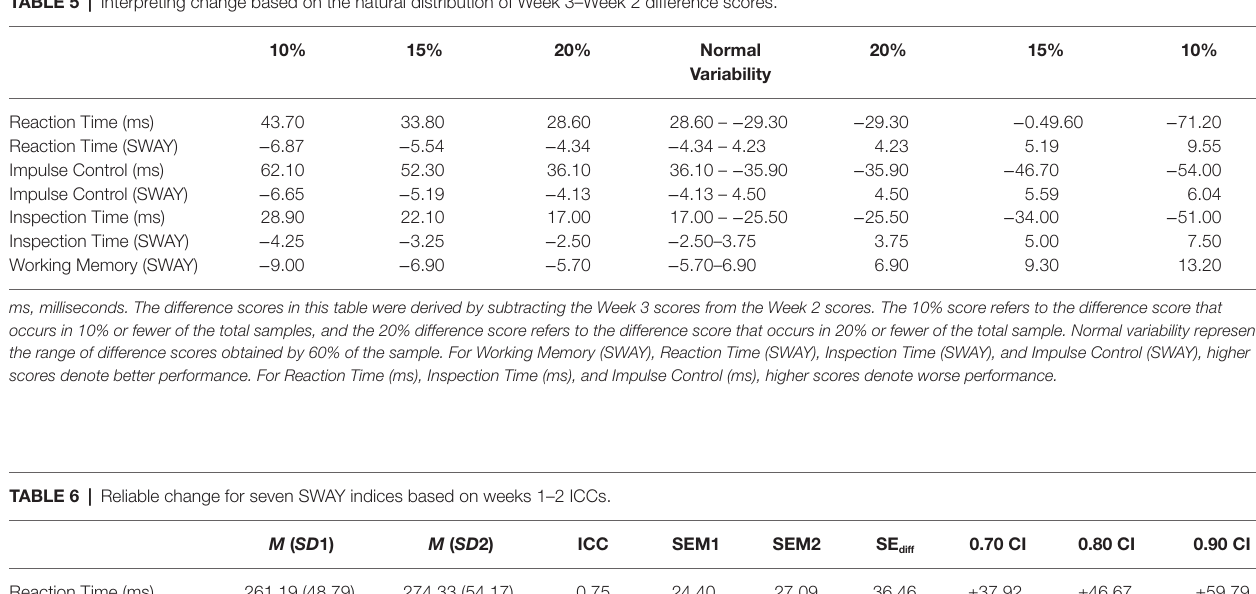
TABLE 5 | Interpreting change based on the natural distribution of Week 3–Week 2 difference scores.